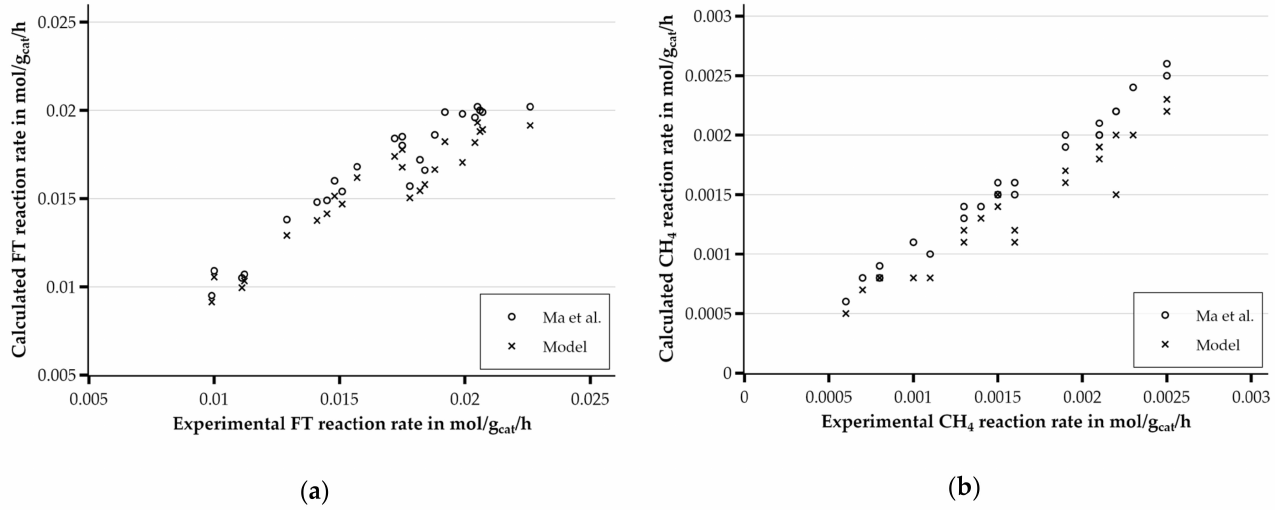
Figure A1. Parity plots for the modeled and literature-based [48,49] ( a ) FT reaction rates and ( b ) methane reaction